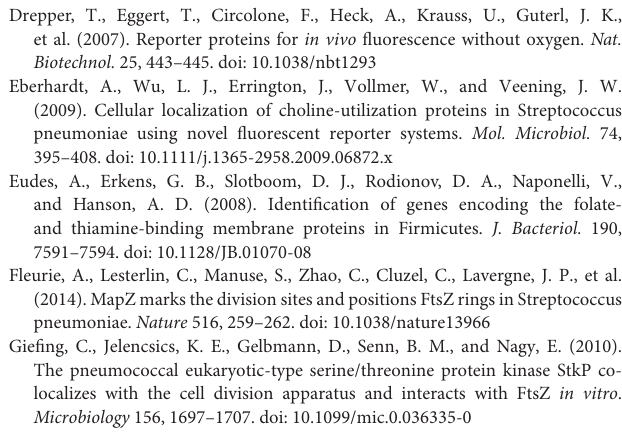
exponential growth phase (OD 600 = 0.2) and GFP + -DivIVa expression was recorded every 30 min for 3 h. Cells were collected, washed and analyzed using flow cytometry. Line plots of the relative fluorescence intensity in course of time of strains MR35 (red), MR49 (blue) and the non-fluorescing S. mutans WT cells (black) are shown. For the generation of line plots the GFP fluorescence of 50,000 individual cells was recorded. The mean and the standard deviation of 3 independent biological replicates are presented. Figure S5 | Dose response curve of the XylS1 promoter cassette to inducer D-xylose in strain MR39. The Gfp + -DivIVa reporter strain MR39 was grown in complex THBY medium to an OD 600 of 0.2. Cells were split in several identical aliquots and treated with different concentrations of D-xylose ranging from 0 to 2.66 ∗ 10 5 µ M. 3 h post induction cells were collected, washed, sonicated and analyzed using flow cytometry. The relative GFP fluorescence intensity of 50000 individual cells was measured for each sample. The corresponding dose response curve is shown in part (A) . In part (B) the dose response is plotted in the logarithmic scale for the inducer concentration (black curve) and the fitted dose response curve assuming sigmoidal dose-response behavior is shown (red line). Based on the fitted curve the EC 50 value was calculated using the software Origin 9.0. Figure S6 | Effect of Carolacton treatment on the localization of cell division protein DivIVa in S. mutans UA159. The chromosomal GFP + -DivIVa reporter strain MR40 carrying the xylose inducible XylS2 promoter cassette was grown in buffered (75 mM and pH 6.5) complex THBY medium to the early exponential growth phase (OD 600 = 0.2). Cells were treated with and without 5.3 µ M Carolacton and GFP + -DivIV expression was induced for all samples (treated/untreated) with 1.5% D-xylose. 3 h post induction cells were harvested, washed and analyzed under the fluorescence microscope. Phase contrast (column A ), fluorescence (column B ) and overlay images (column C ) of Carolacton treated (upper panel T) and untreated control cells (lower panel C ) are presented. Figure S7 | Effect of Carolacton treatment on the localization of cell division protein PknB in S. mutans UA159. The chromosomal GFP + -PknB reporter strain carrying the xylose inducible XylS2 promoter cassette (MR43) was grown in buffered (75 mM and pH 6.5) complex THBY medium to the early exponential growth phase (OD 600 = 0.2). Cells were treated with and without 5.3 µ M Carolacton and GFP + -PknB expression was induced for all samples (treated/untreated) with 1.5% D-xylose. 3 h post induction cells were harvested, washed and analyzed under the fluorescence microscope. Phase contrast (column A ), fluorescence (column B ) and overlay images (column C ) of Carolacton treated (upper panel T) and untreated control cells (lower panel C ) are presented. Figure S8 | THMM prediction of transmembrane helices for the hypothetical proteins SMU_503 and SMU_609. The amino acid sequence of the proteins was analyzed using the TMHMM server version 2.0. The plot shows the posterior probabilities of inside/outside/transmembrane helix for each residue. Table S1 | Plasmids used in this